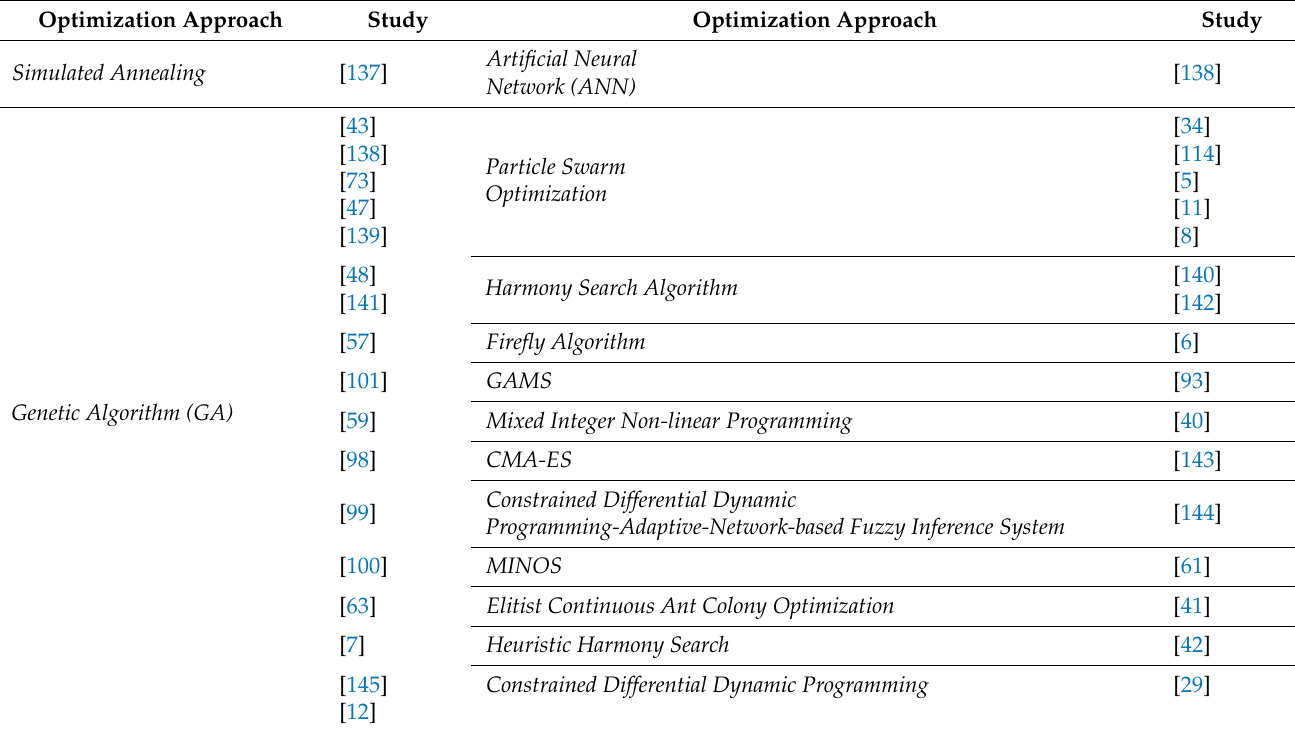
Table 4. Classification of different single-objective metaheuristic groundwater optimization models. Optimization